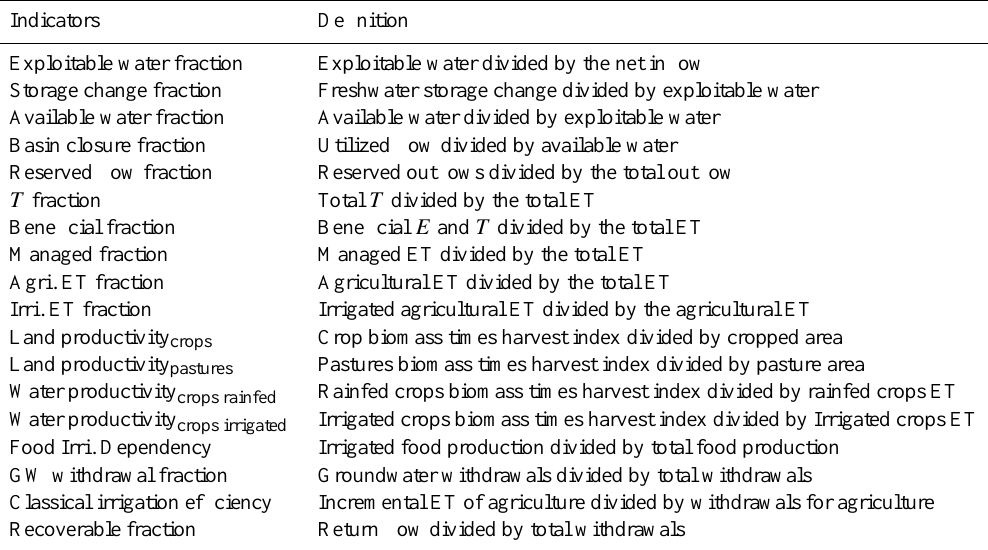
Table A1. WA + indictors